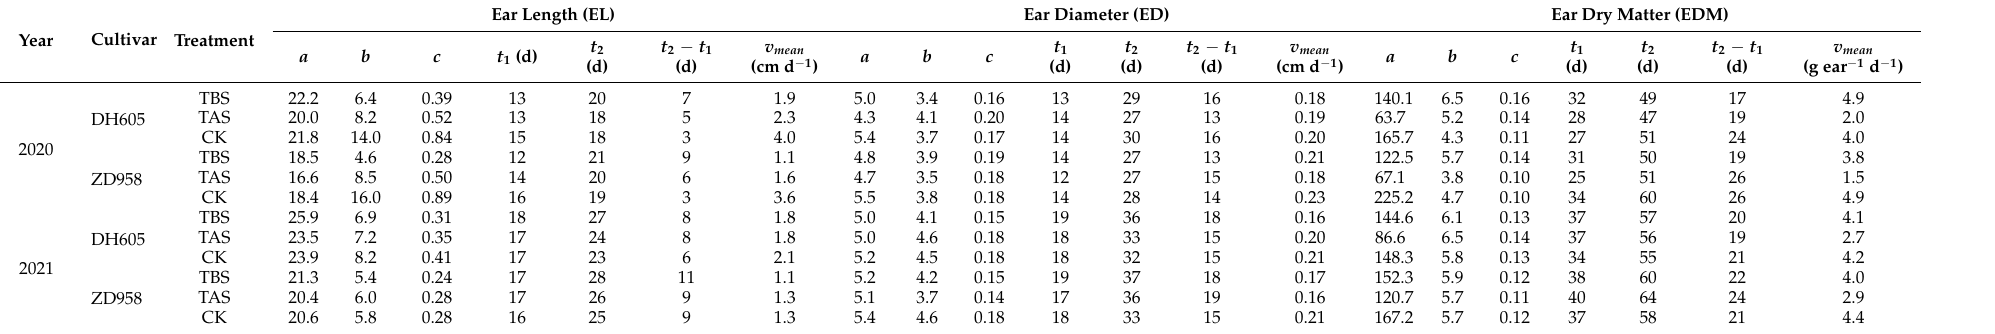
Table 1. Fitted parameters for the logistic equation to model ear length, ear diameter and ear dry matter growth process under different heat stress treatments. The parameters in the table were derived from all data of three sowing dates for each